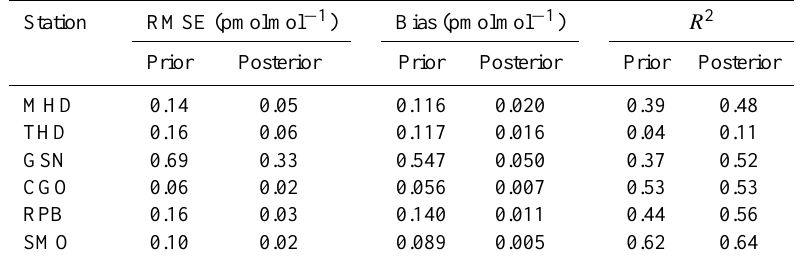
Table 1. Model performance metrics. The first two columns show the root-mean-square error (RMSE) for the prior and posterior models compared to the observations. The middle columns show the mean bias between the model and observations. The final two columns show the squared correlation coefficient for the de-trended models and observations. In all cases the a posteriori initial conditions have been added to the derived mole